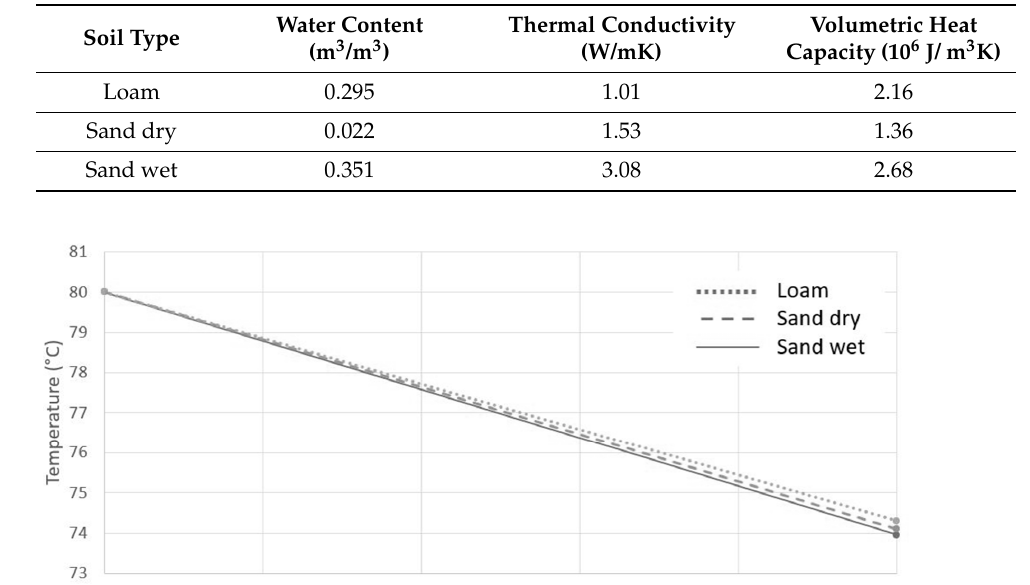
Table 1. Soil properties [10].